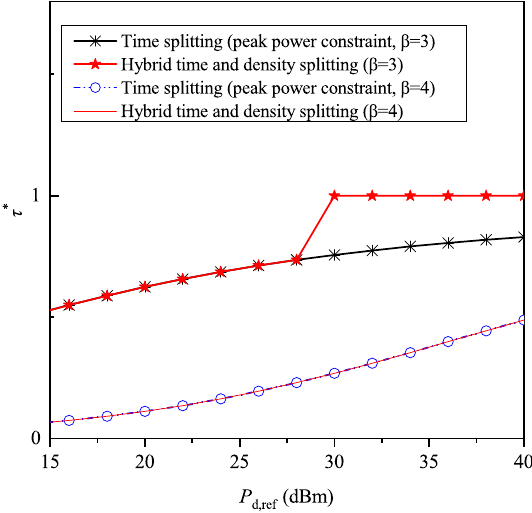
Figure 6. Optimized τ versus P d,ref for β = 3 and β =